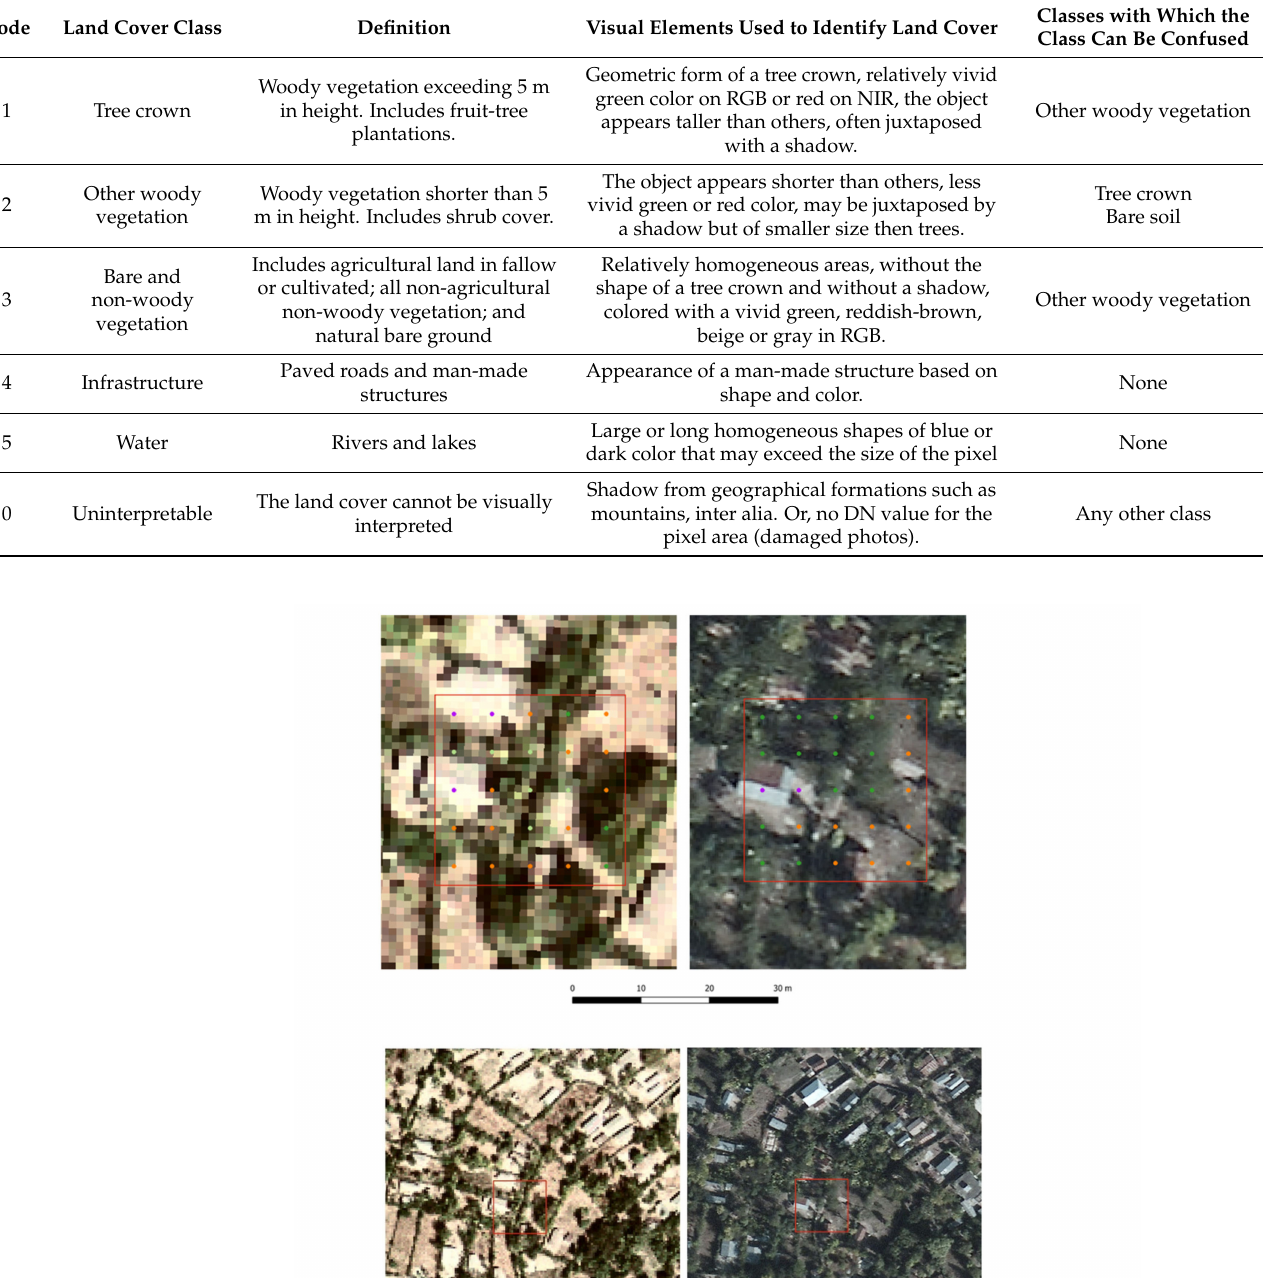
Table 2. Land cover classes, definitions, and potential sources of commission or omission errors.